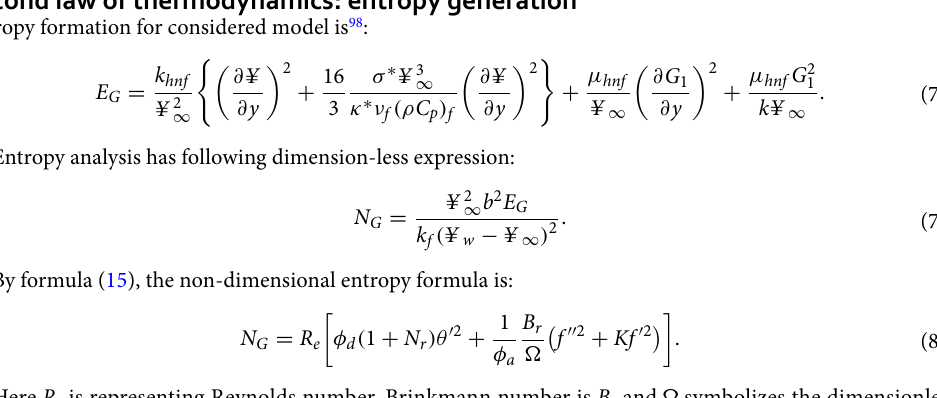
Figure 6. Variations in temperature regarding N r